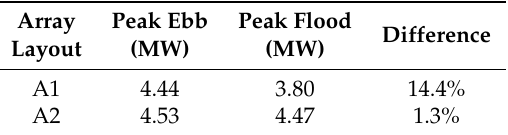
Table 3. Power output at peak ebb and flood of a mean spring tide for array configuration A1 (initial) and A2 (optimized) (adapted from